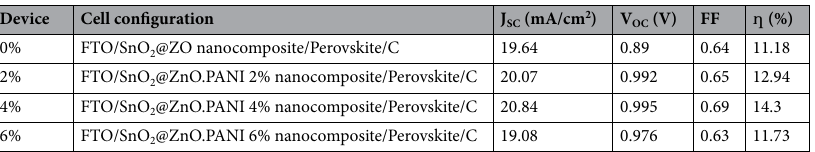
Table 2. Photovoltaic performance of PSCs containing SnO 2 @ZnO.PANI (0%, 2%, 4%, and 6%) nanocomposite as